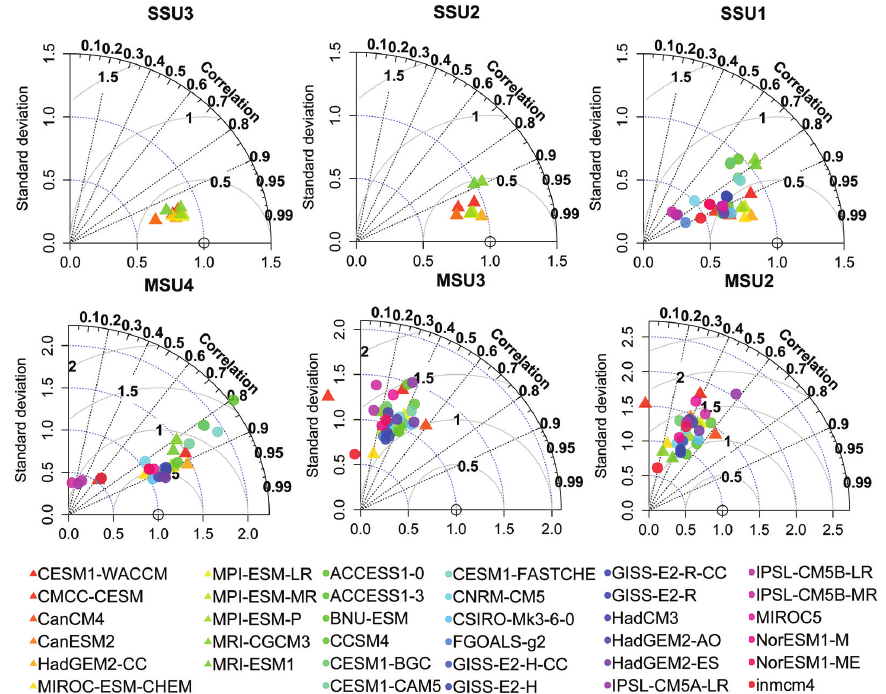
Figure 3. Taylor diagram for time series of observed and simulated global mean temperature. Normalized Standard deviation, Correlation coefficient, and The Root Mean Squared Deviation (RMSD) are presented in one diagram. An ideal model has a standard deviation ratio of 1.0 and a correlation coefficient of 1.0. Triangle symbols represent high-top models (correlations greater than 0.14 are statistically significant at the 99% confidence level).